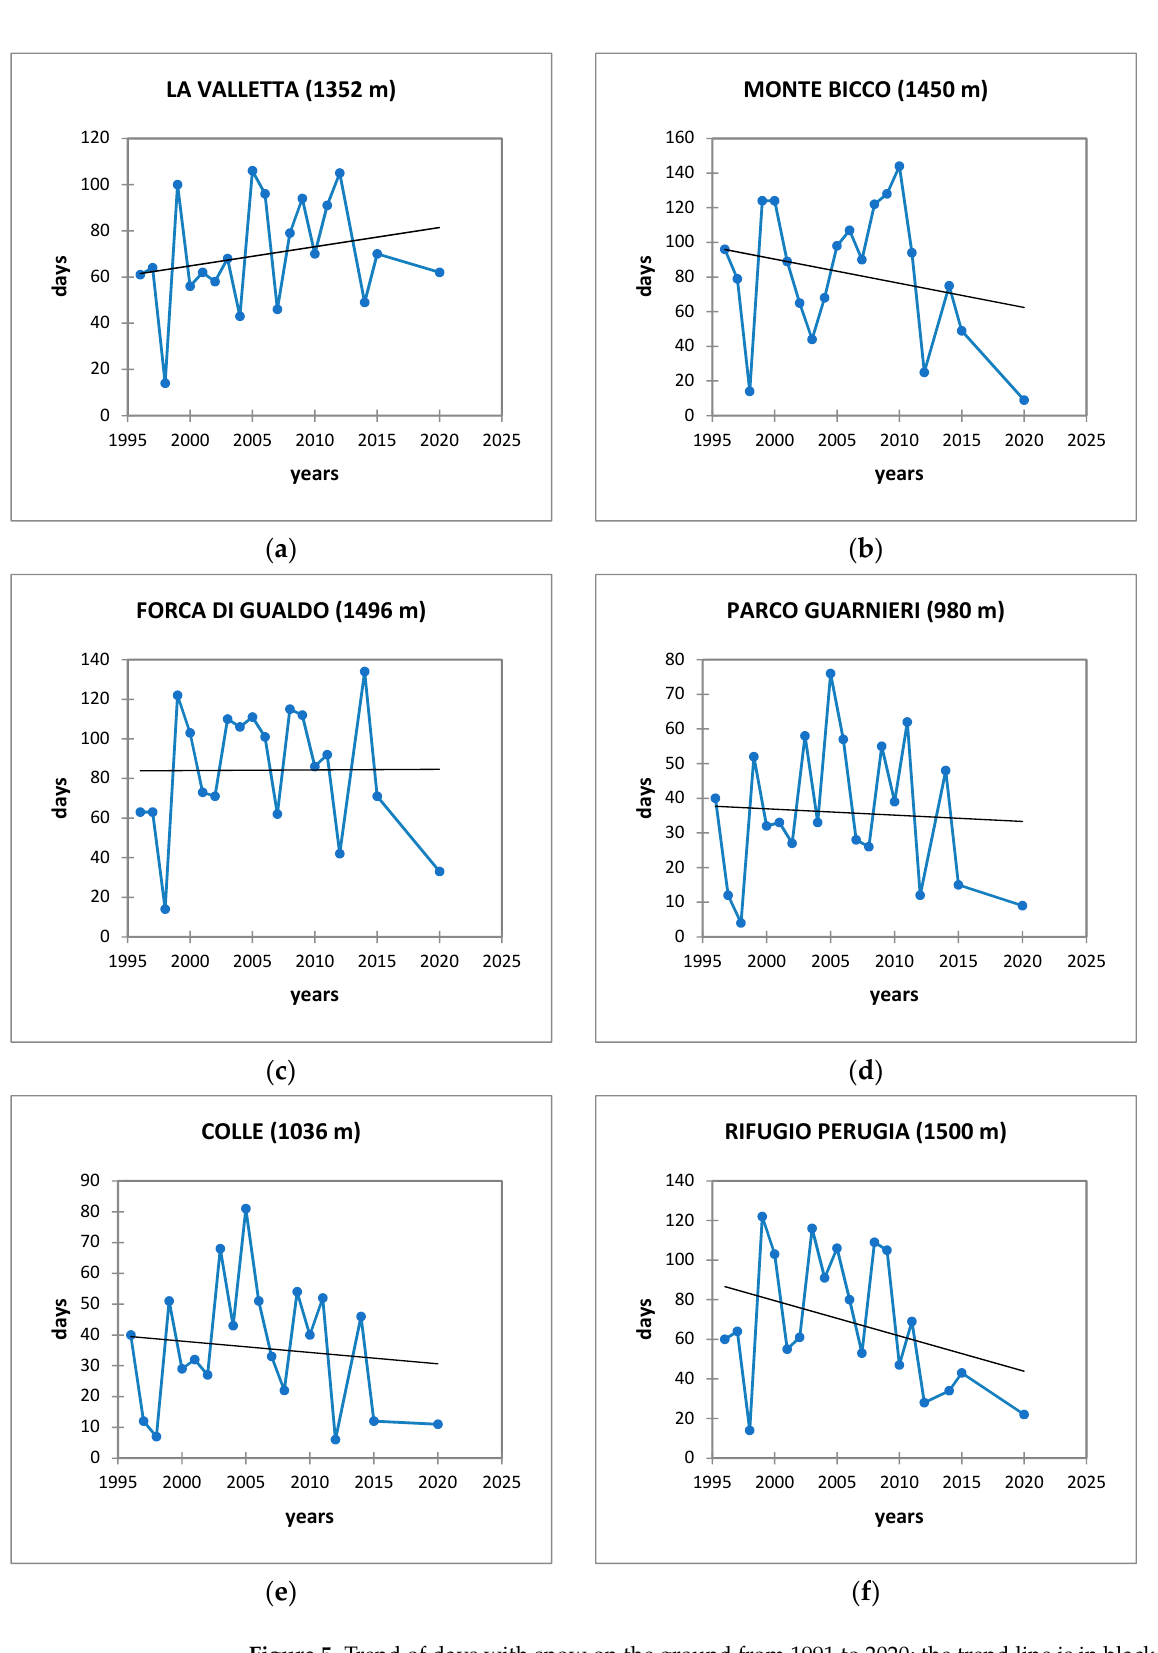
Figure 5. Trend of days with snow on the ground from 1991 to 2020; the trend line is in black, for the weather stations: ( a ) La Valletta, ( b ) Monte Bicco, ( c ) Forca di Gualdo, ( d ) Parco Guarnieri, ( e ) Colle, ( f ) Rifugio